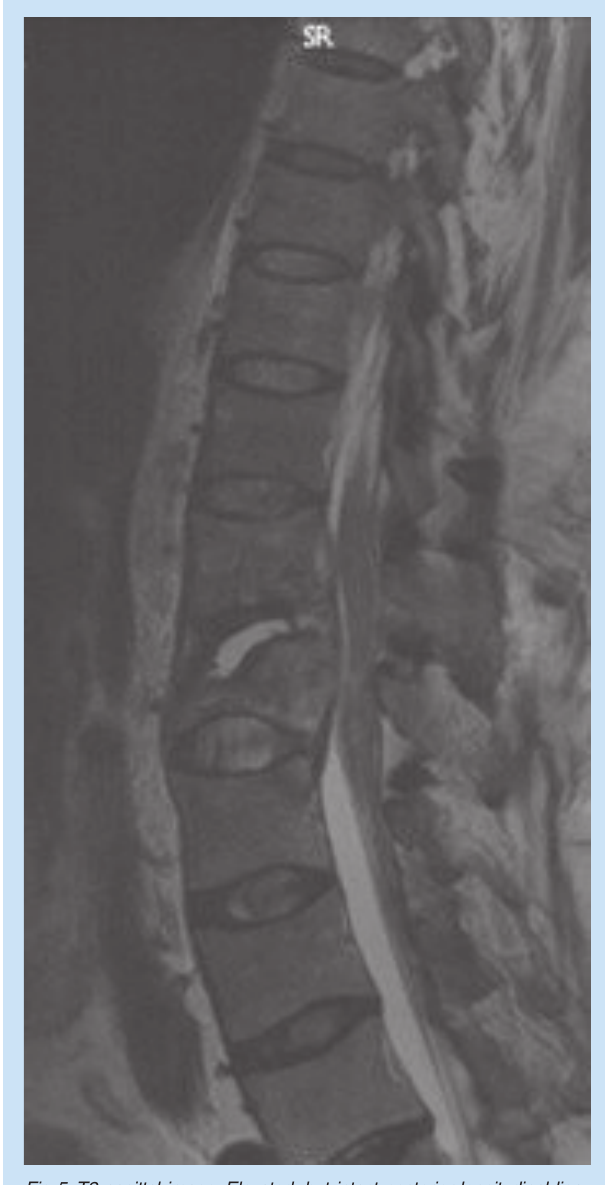
Fig 5. T2 sagittal image. Elevated, but intact posterior longitudinal liga-